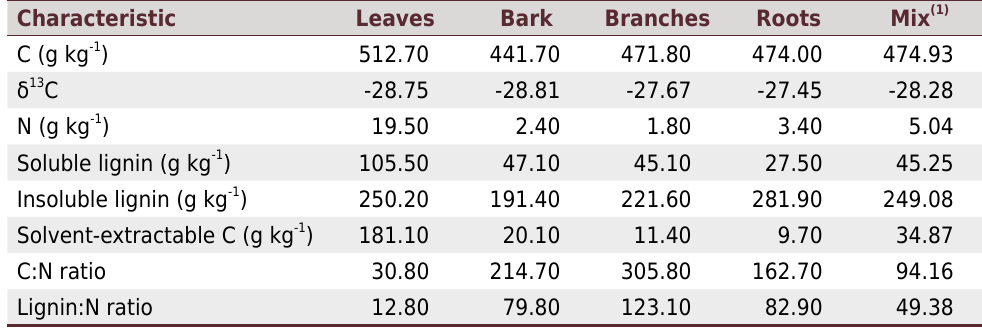
(1) Mixture of leaves, bark, branches, and roots at the relative proportions of 12.9, 26.4, 12.7, and 49 %, respectively. Values are given by the weighted mean of the